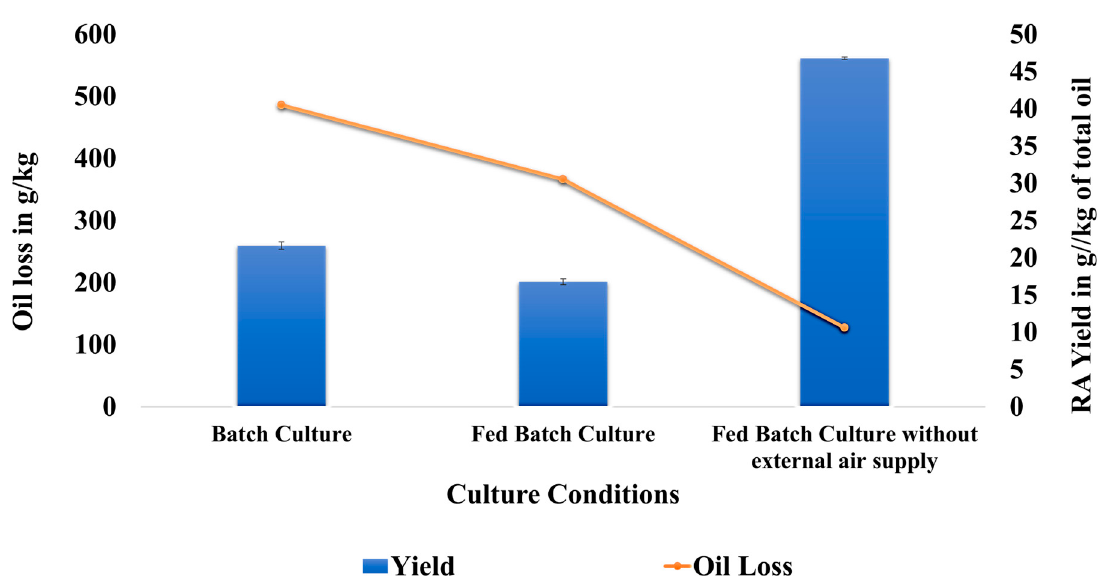
Figure 10. Graph representing ricinoleic acid yield and oil loss observed in batch culture, fed-batch culture, and fed-batch culture without an external air supply.